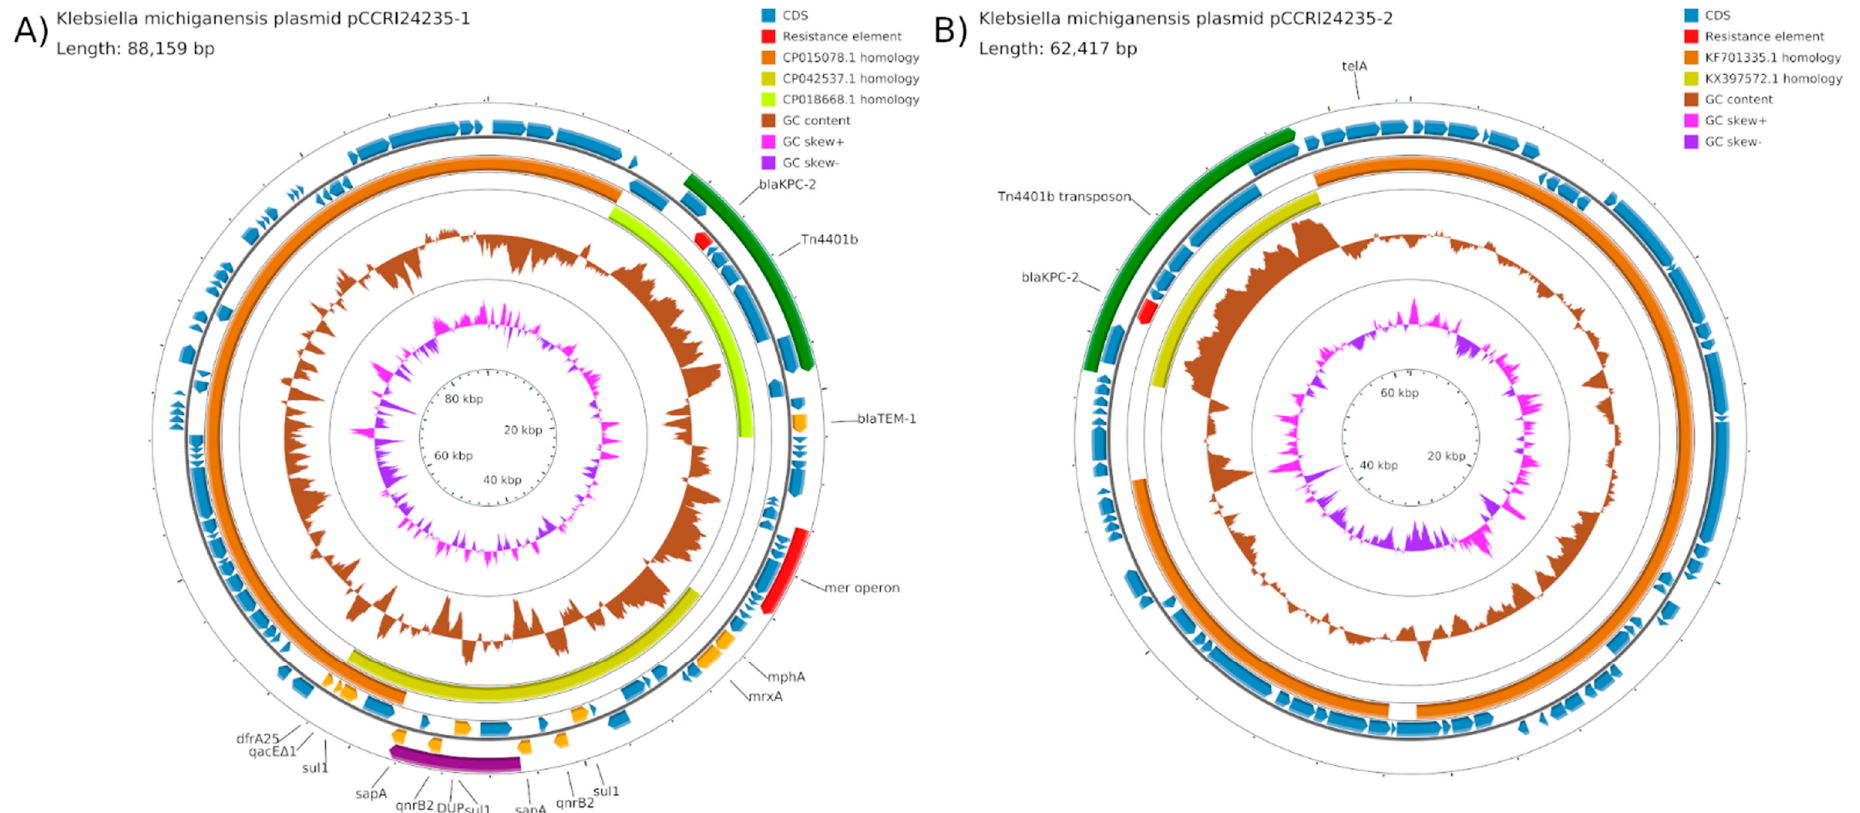
Figure 2. ( A ) Map of plasmid pCCRI24235-1. The scales are indicated on the innermost circles. The second circles are G+C skew in pink (+) and purple ( − ), and circles 3 show G+C content (deviation from the average) in brown (+, outward and − , inward). The next two circles illustrate regions homologous to related plasmids. The following two circles show positions of CDSs in minus (circle 4) and plus (circle 5) strands in dark blue. The bla KPC-2 gene is indicated in red. Transposon Tn 4401b is indicated by a green arc. The segment absent in pCCRI24236-2 (DUP) is indicated by a purple arc. ( B ) Map of plasmid pCCRI24235-2. Transposon Tn 4401b , indicated in green, is absent in pCCRI24236-3.